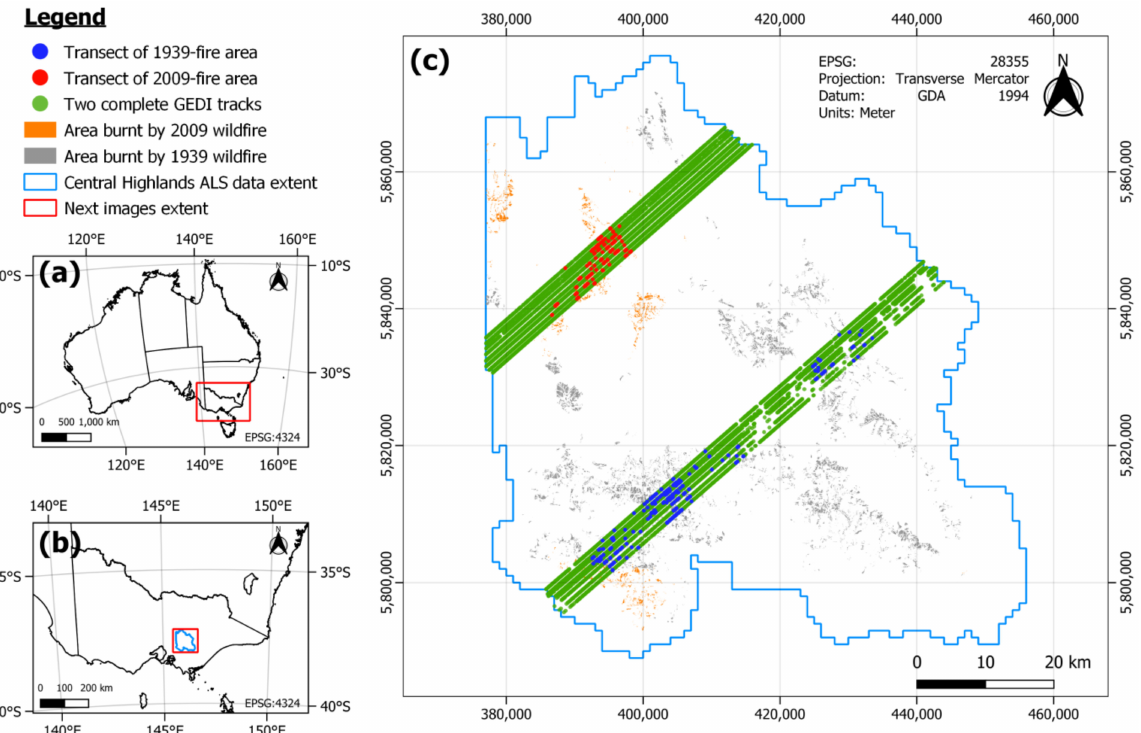
Figure 1. Map of the study area within ( a ) Australia and ( b ) the state of Victoria. The main map ( c ) de- picts two tracks of GEDI footprints (green) used for the landscape level analysis. GEDI footprints that overlap mountain ash forest areas burnt in 2009 and 1939 are displayed in red and blue, respectively. The outline polygon in blue showing the study area is the forested area covered by an airborne LiDAR scanning (ALS) survey project in the Central Highlands of Victoria in 2015–2016 carried out by the Victorian Department of Environment, Land, Water, and Planning